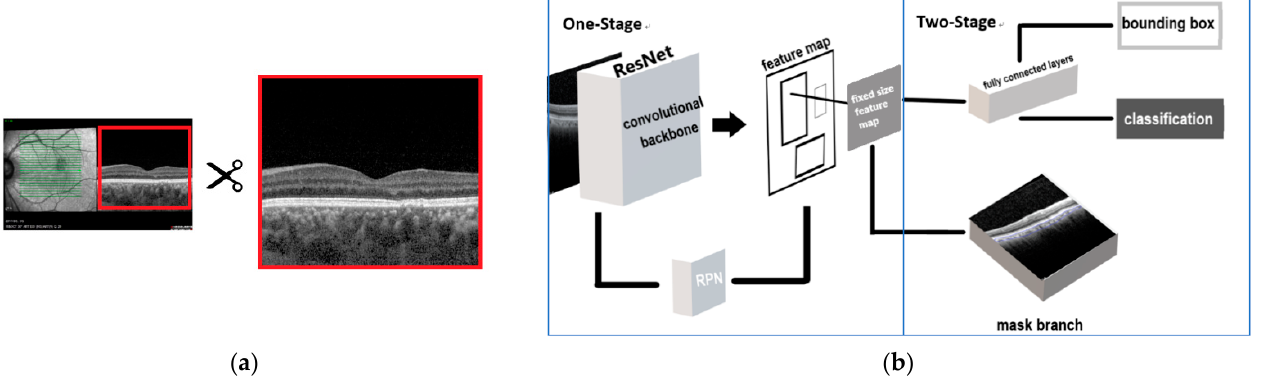
Figure 2. ( a ) Image slice is cropped from an original 2D scan for Mask R-CNN to train and test and reduce unnecessary information. ( b ) The Mask R-CNN framework of OCT segmentation. The OCT image will input to convolutional layers and RPN. The feature map is combined with the results of the FPN to generate candidate objects and extract details to generate a mask of the choroid.